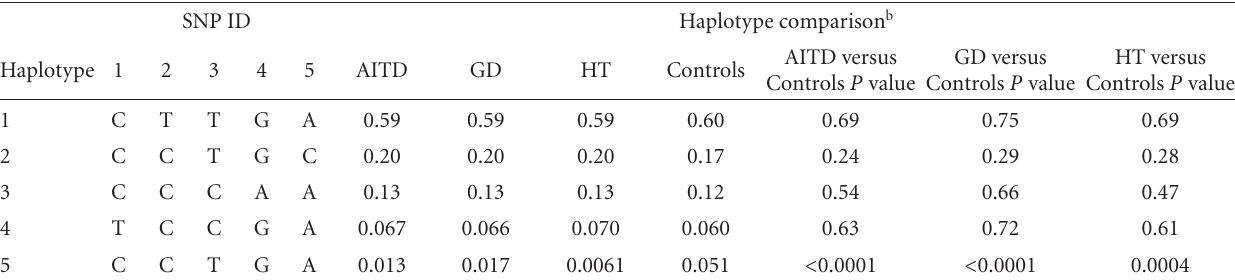
Table 1: PTPN22 haplotype structure and frequencies a